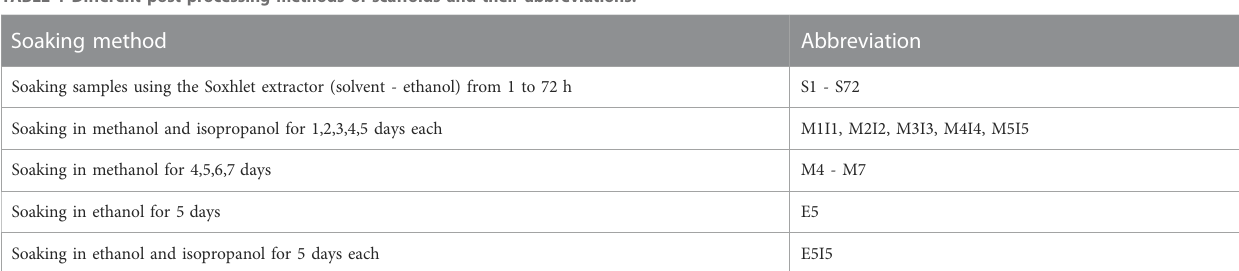
TABLE 1 Different post-processing methods of scaffolds and their abbreviations. Soaking